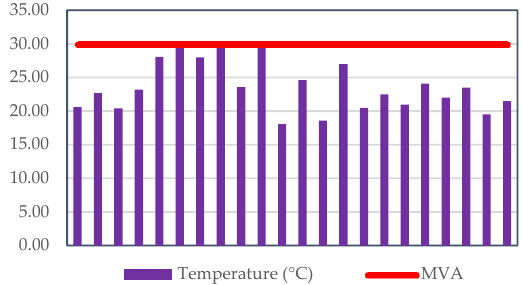
Figure 8. Temperature of the groundwater in the T.O.C. (March 2017).